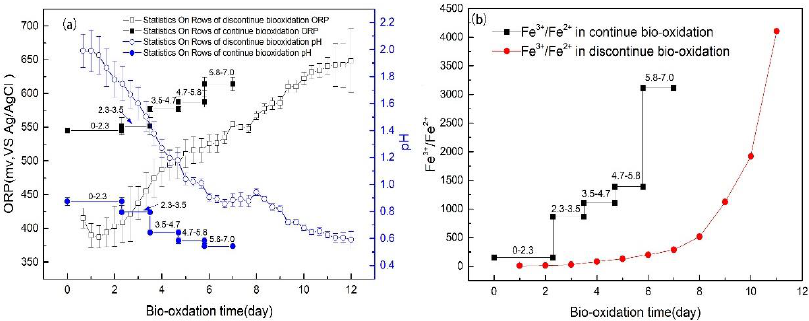
Minerals 2021 , 11 , 1343 Figure 6. ORP and pH trend during continuous and batch bio-oxidation process. Figure 6. ORP and pH trend during continuous and batch bio-oxidation process.